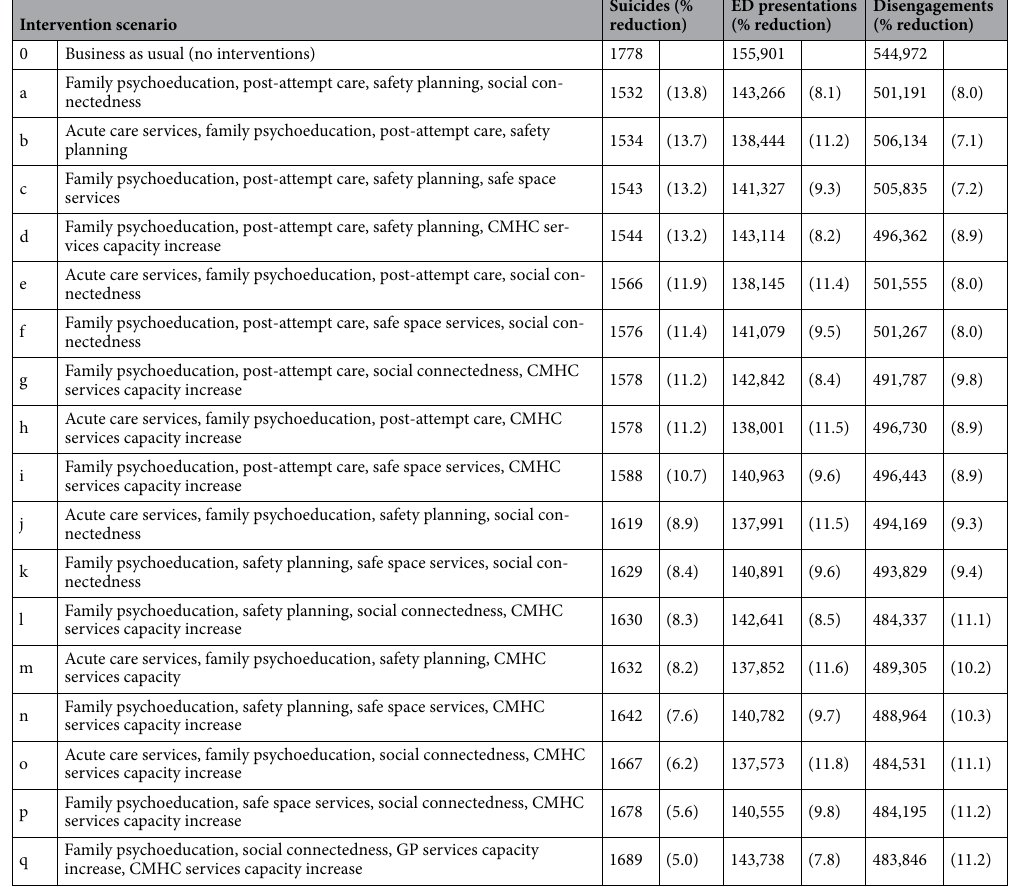
Table 2. Non-dominated solutions for the hunter New England and central coast primary health network (HNECC PHN). Each solution is a combination of four interventions that performs better than all other combinations on at least one outcome, preventing more suicides, mental health-related emergency department (ED) presentations, and/or disengagement. Numbers of suicides, mental health-related ED presentations, and patients disengaging across the PHN over the period 2021–2031 are presented for each intervention